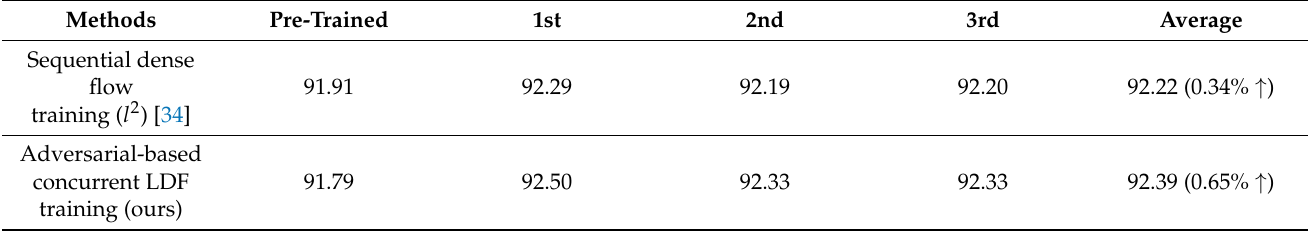
Table 4. Accuracy (%) of CIFAR-10 for the 26-layer pre-trained and 20-layer target ResNets. Methods